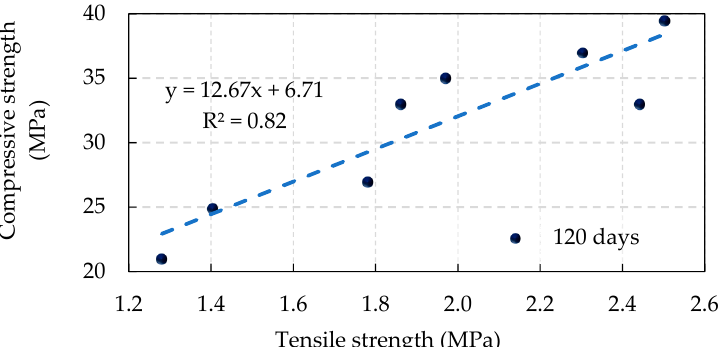
Figure 10. Relationship between the splitting tensile strength and compressive strength of all specimens.